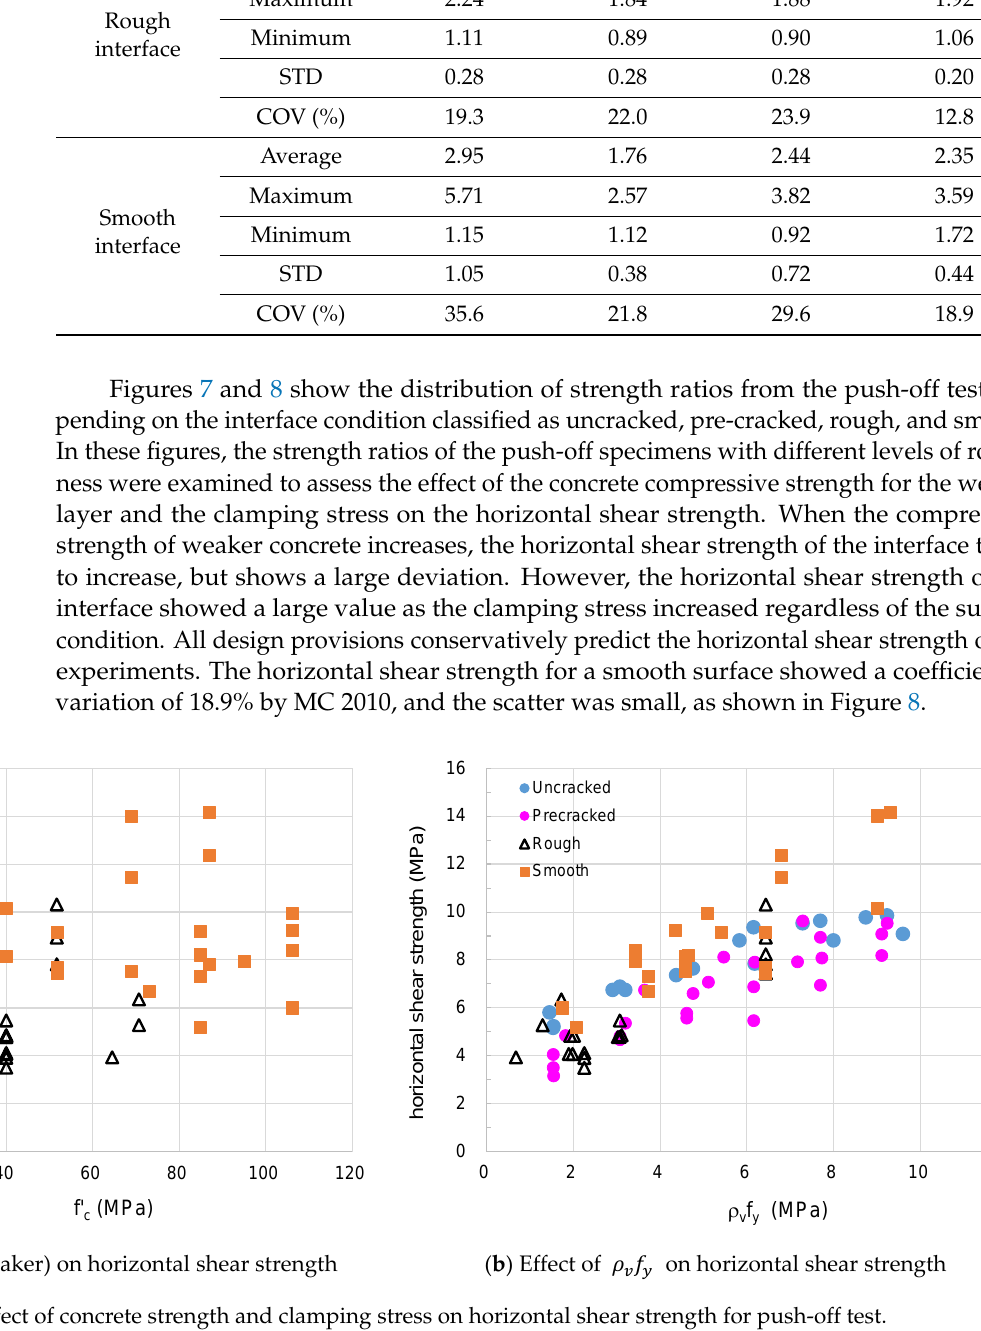
Figure 7. Effect of concrete strength and clamping stress on horizontal shear strength for push-off test.